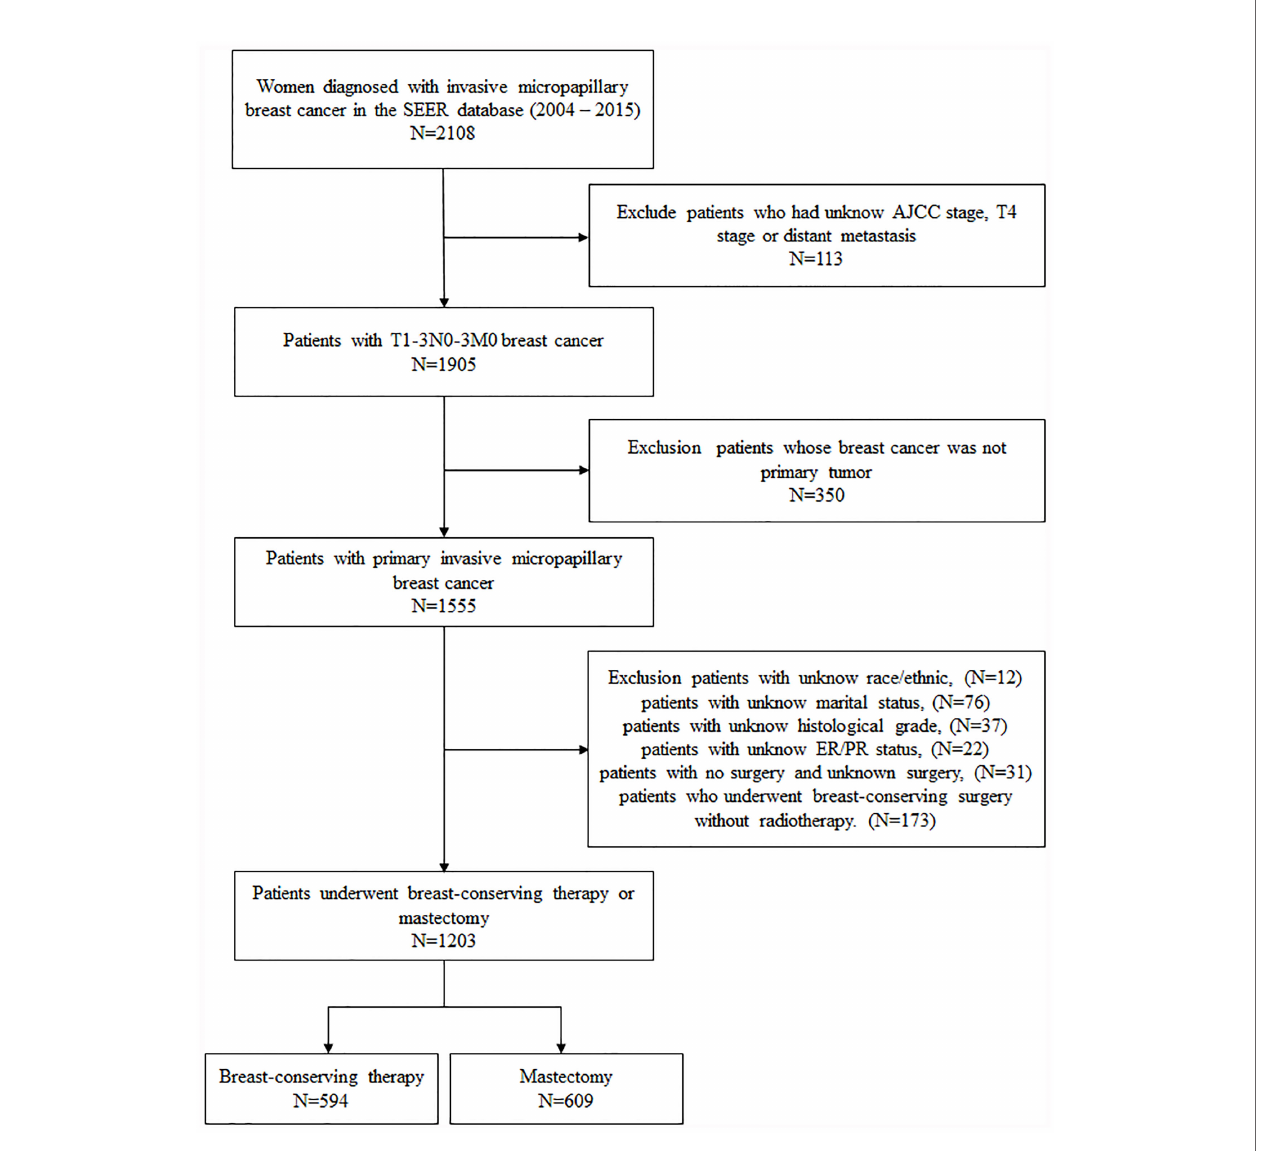
FIGURE 1 | Flow chart of the study